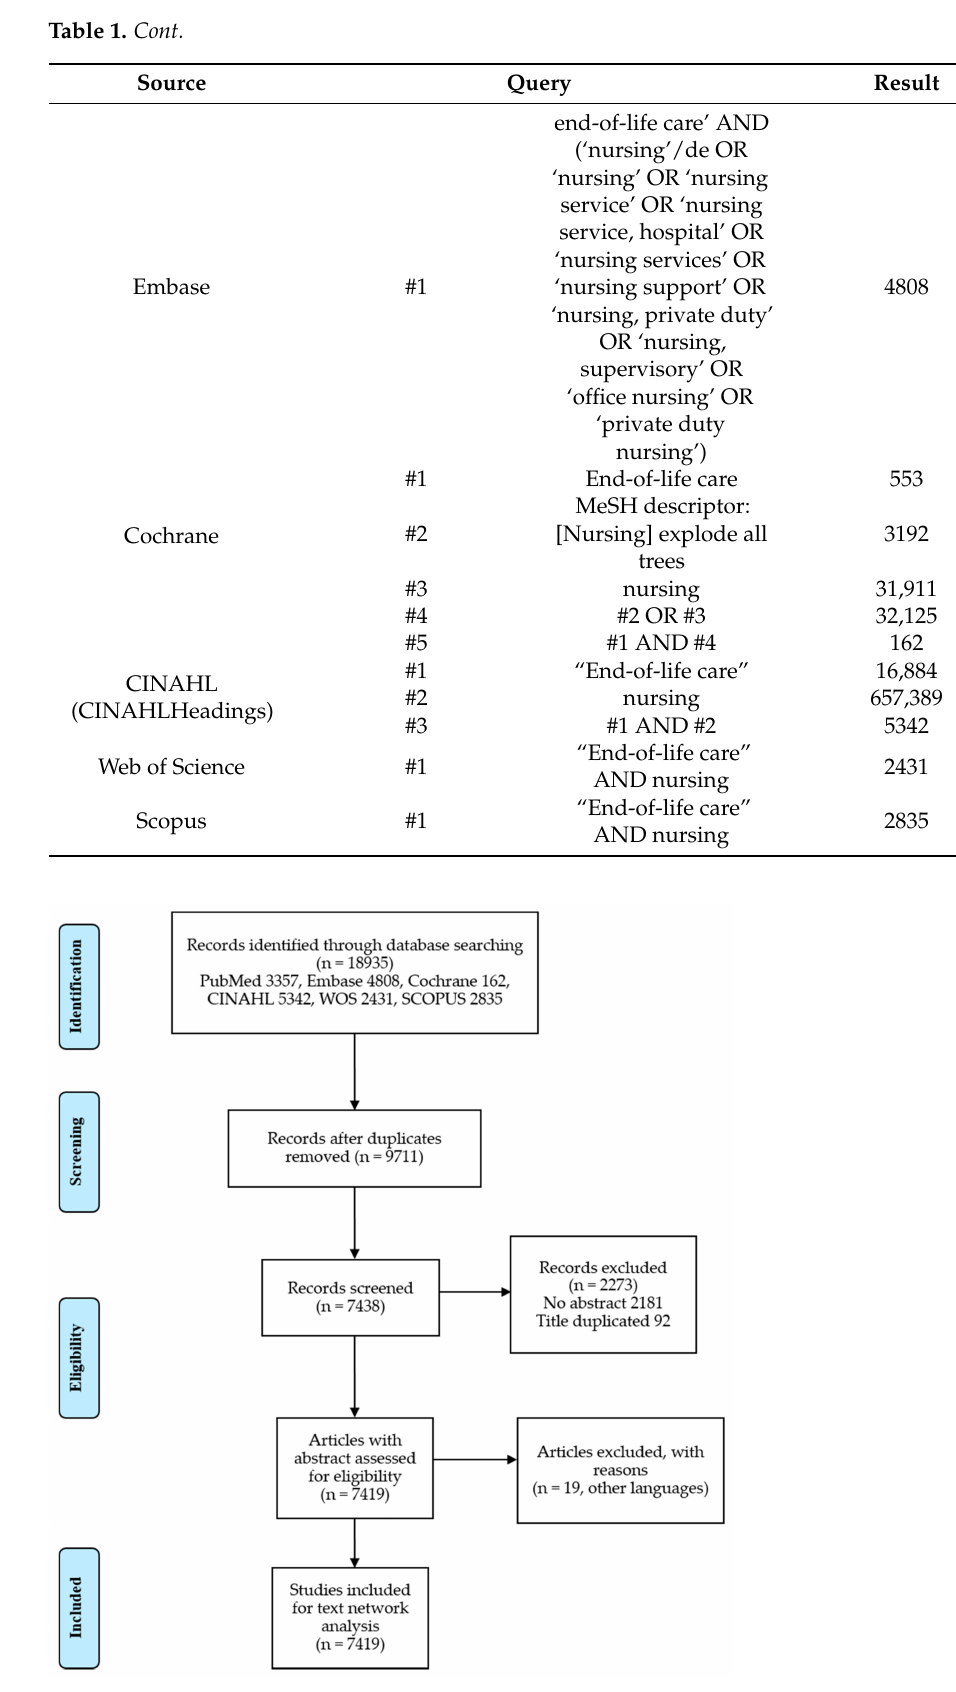
Figure 1. Process of article